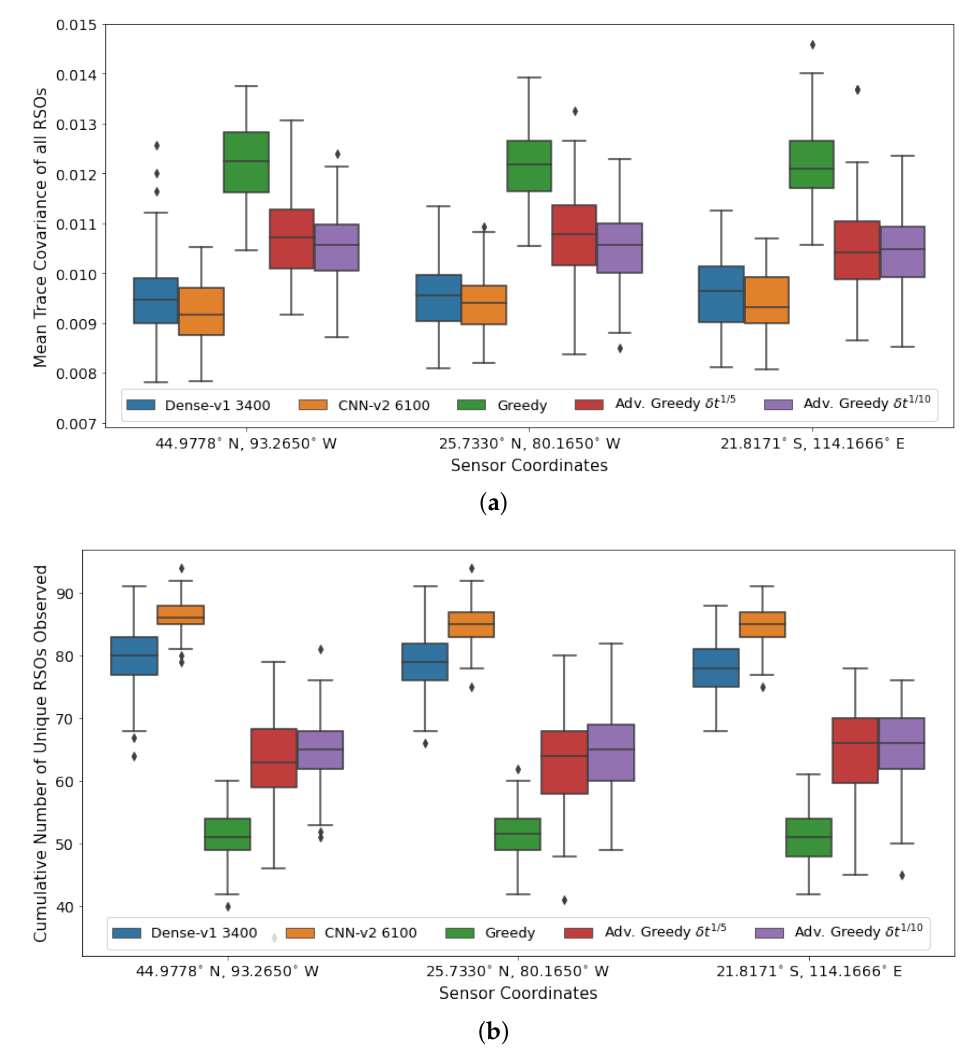
Figure 14. Aggregate performance of the DRL agents with 100 randomly initialized GEO RSOs, evalu- ated over 100 seeded rollouts of 90 min each and using varying sensor coordinates. ( a ) Distribution of the final mean trace covariance at the end of the observation window (lower is better); ( b ) Distribution of the cumulative number of unique RSOs observed at the end of the observation window (higher is better). Note: CNN-v2 6100 represents a CNN-v2 DRL agent trained for 6100 training